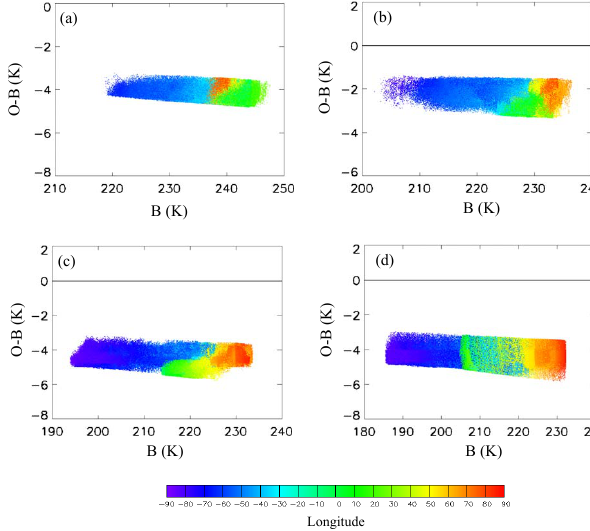
Figure 7. Scatter plots of the differences of brightness temperature between observations and model simulations for MWTS-2 (a) chan- nel 5, (b) channel 6, (c) channel 7, and (d) channel 8 outliers during 1–5 July 2011.